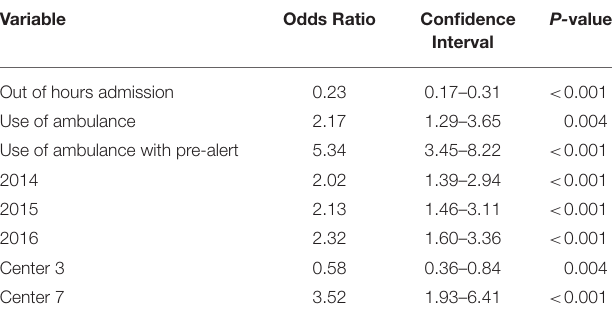
TABLE 4 | Binary logistic regression analysis for door-to-needle processing times under 60min (results relative to 2013, center results relative to center